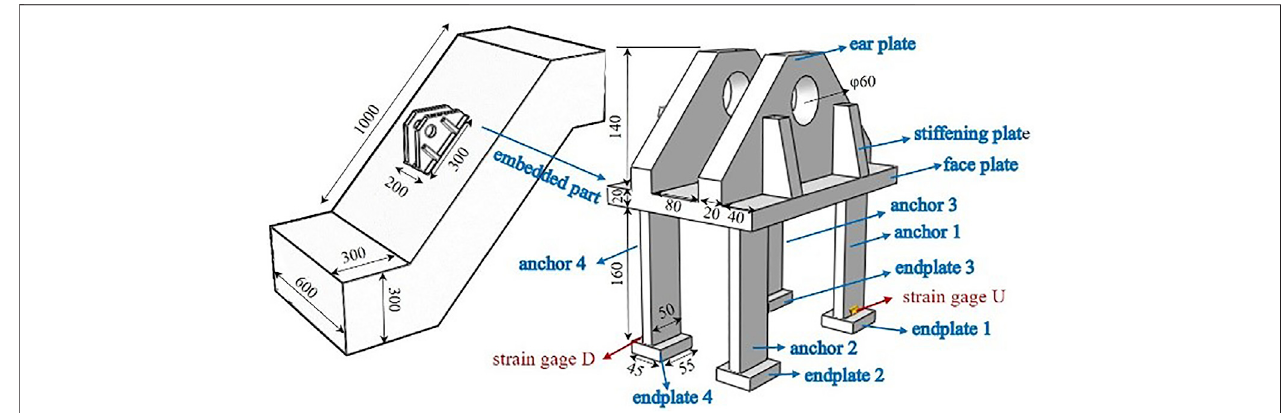
FIGURE 4 | Dimensions and composition of BFJ and PESC